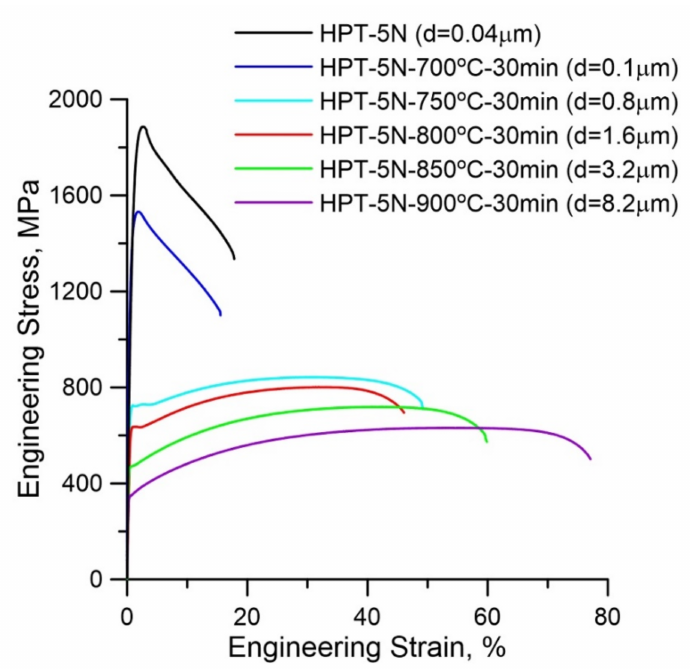
Figure 5. Tensile results of HPT-produced 316LN stainless steels after annealing.